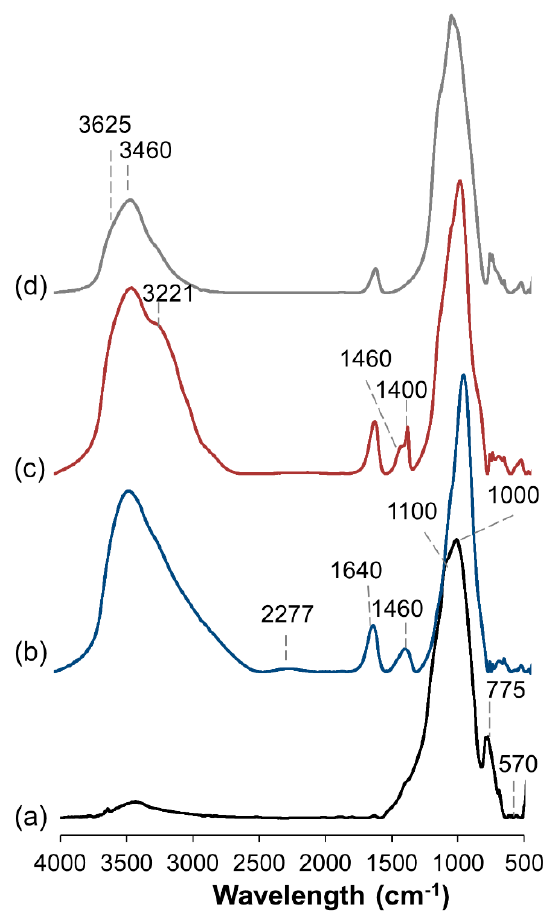
Figure 3. Representative Fourier Transform Infrared Spectroscopy (FTIR) spectra of Huntly-GP. ( a ) raw Huntly-FA; ( b ) FA-based geopolymer “as-synthesised”; ( c ) NH 4+ -form of the geopolymer; ( d ) NH 4+ -geopolymer after heating to 550